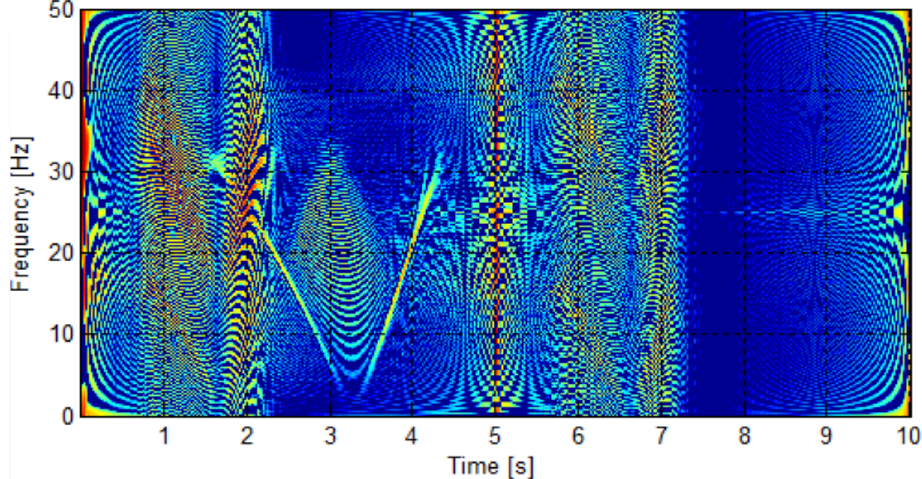
Figure 4. Wigner–Ville distribution of the LSHst of the simulated machine, in the time-frequency